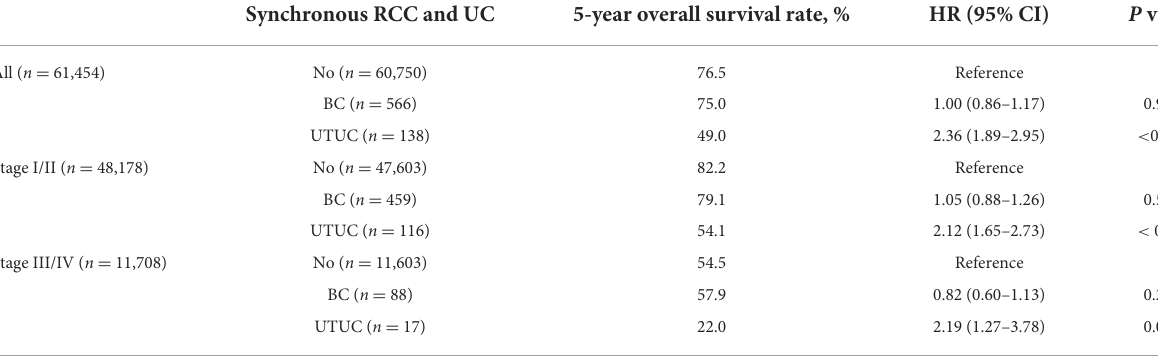
TABLE 3 Overall survival according to multivariate analysis in different groups a